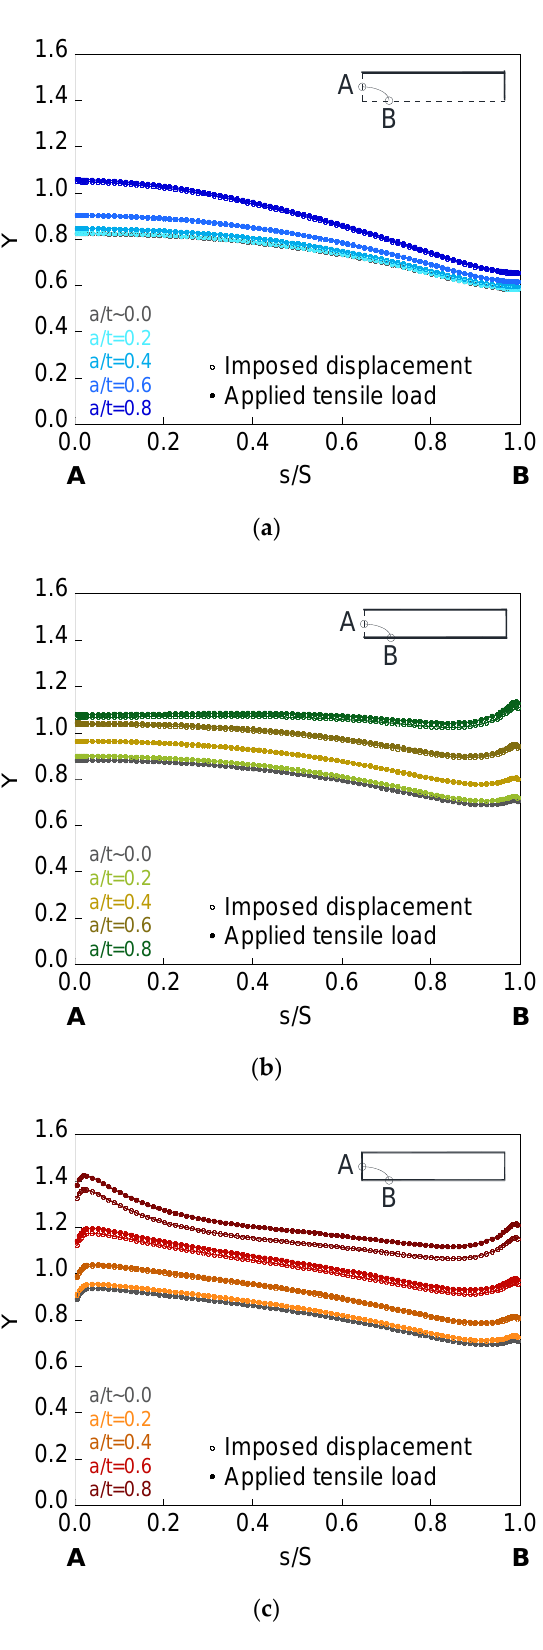
Figure 9. Dimensionless SIF for cracks of relative depths a / t = {~0.0, 0.2, 0.4, 0.6, 0.8} and aspect ratio a / b = 0.5 in a finite-thickness plate for the ( a ) embedded configuration, ( b ) superficial configuration, and ( c ) corner configuration.